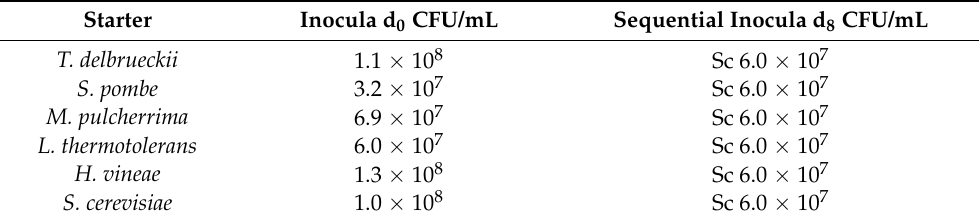
Table 1. Population determined with plate counting for each inoculum. The two first columns indicate the inocula used as fermentation starter (d 0 ), and the third column refers to the inoculum used for the sequential fermentation with Sc (d 8